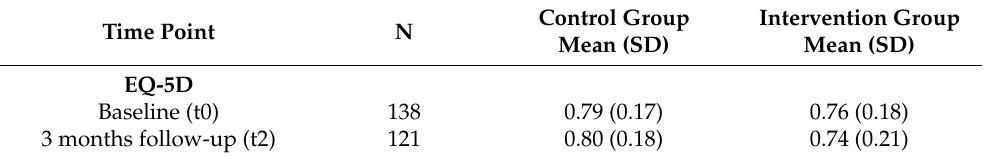
Table 3. Mean EQ-5D utility score per time point.